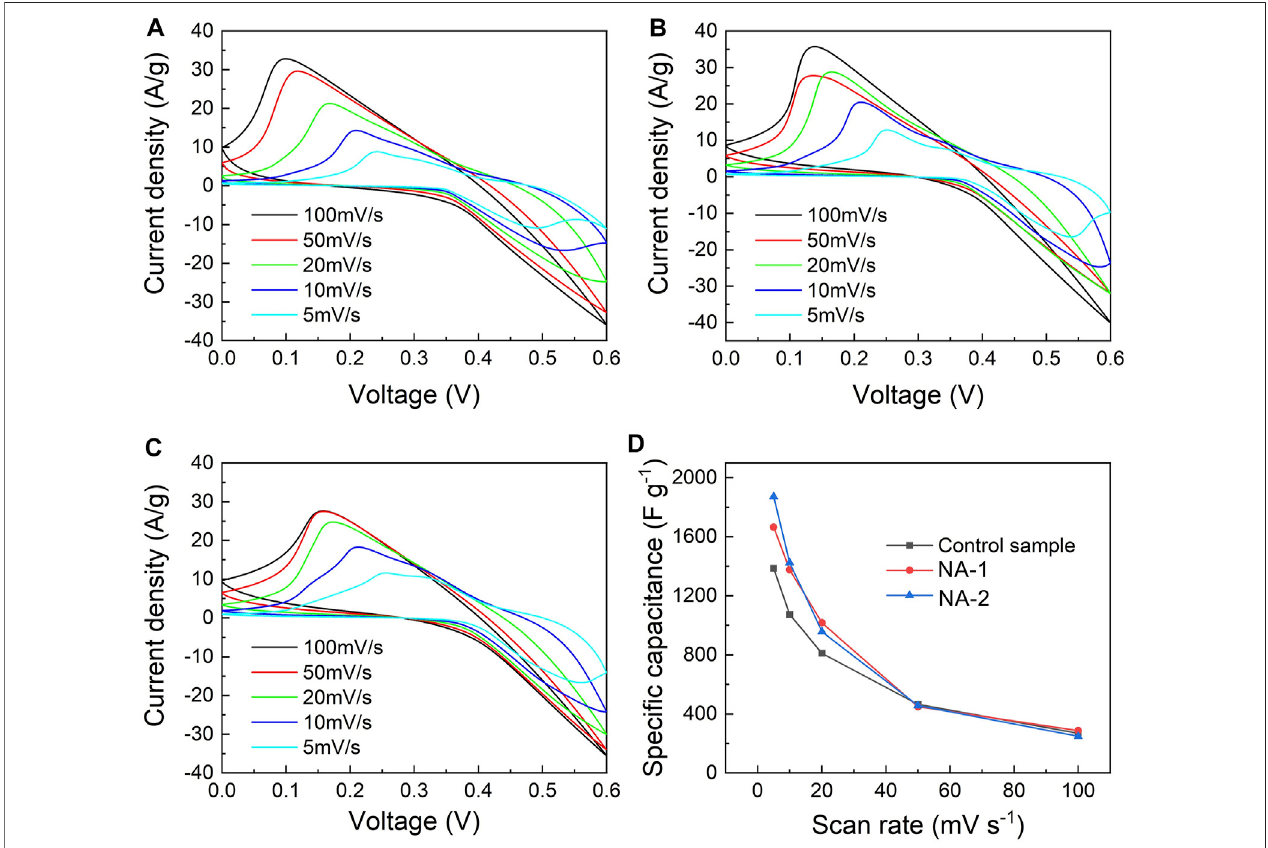
FIGURE 4 | CV curves at the scanning rate of 5 – 100 mV s − 1 of the (A) control, (B) NA-1, and (C) NA-2 samples and (D) scanning rate dependence of speci fi c capacity for the control, NA-1, and NA-2 samples.